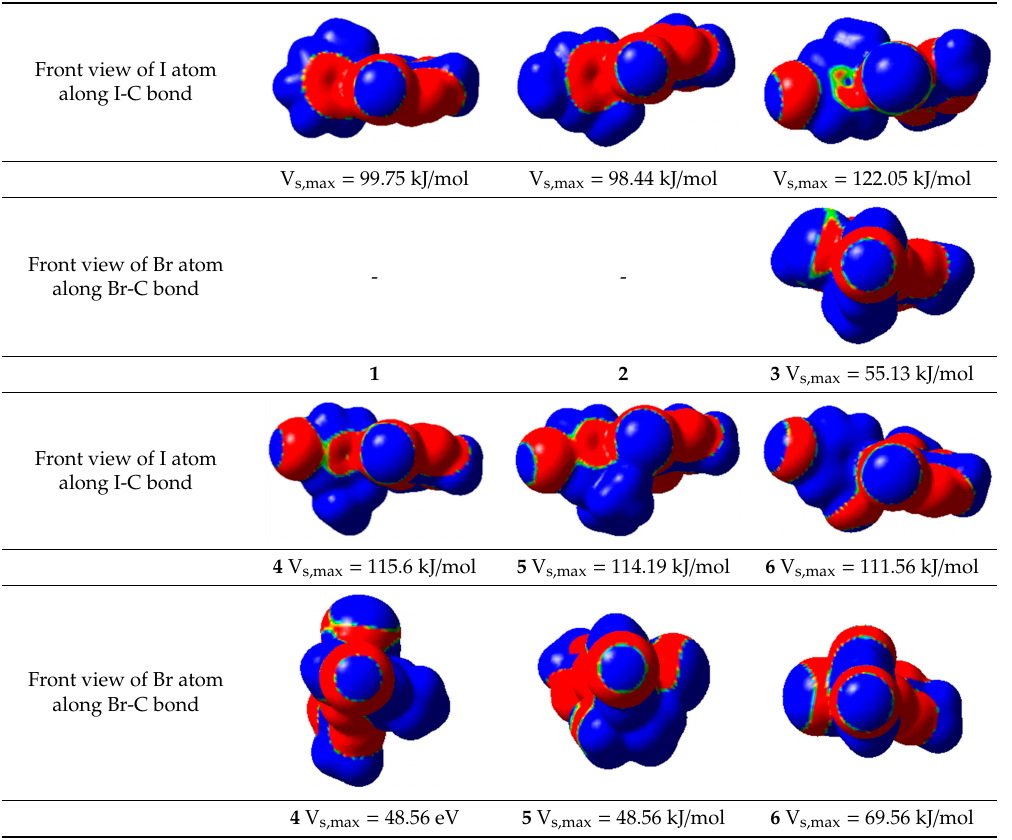
Table 3. The electrostatic surface potential (ESP) of 1 – 6 , mapped over 0.001 a.u. showing the σ -hole of Table 3. The e lectrostatic surface potential (ESP) of 1 – 6 , mapped over 0.001 a.u. showing the σ -hole Table 3. The e lectrostatic surface potential (ESP) of 1 – 6 , mapped over 0.001 a.u. showing the σ -hole Table 3. The e lectrostatic surface potential (ESP) of 1 – 6 , mapped over 0.001 a.u. showing the σ -hole Table 3. The e lectrostatic surface potential (ESP) of 1 – 6 , mapped over 0.001 a.u. showing the σ -hole the iodine and bromine atoms. of the iodine and bromine atoms . of the iodine and bromine atoms . of the iodine and bromine atoms . of the iodine and bromine atoms .